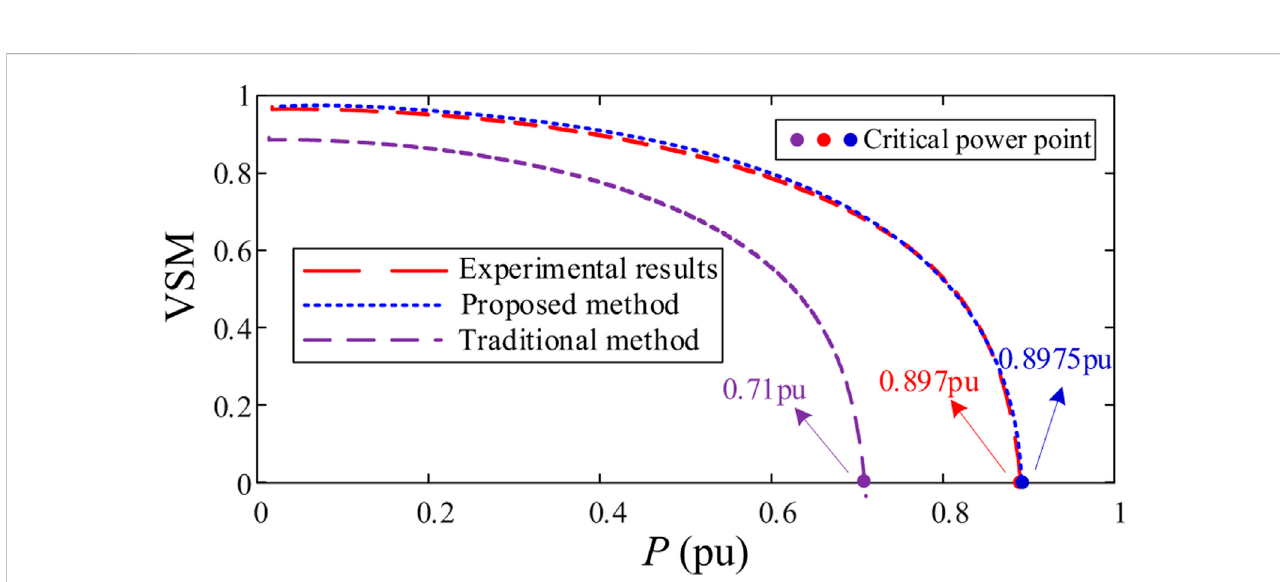
FIGURE 10 Comparison between different stability margin evaluation models and experimental